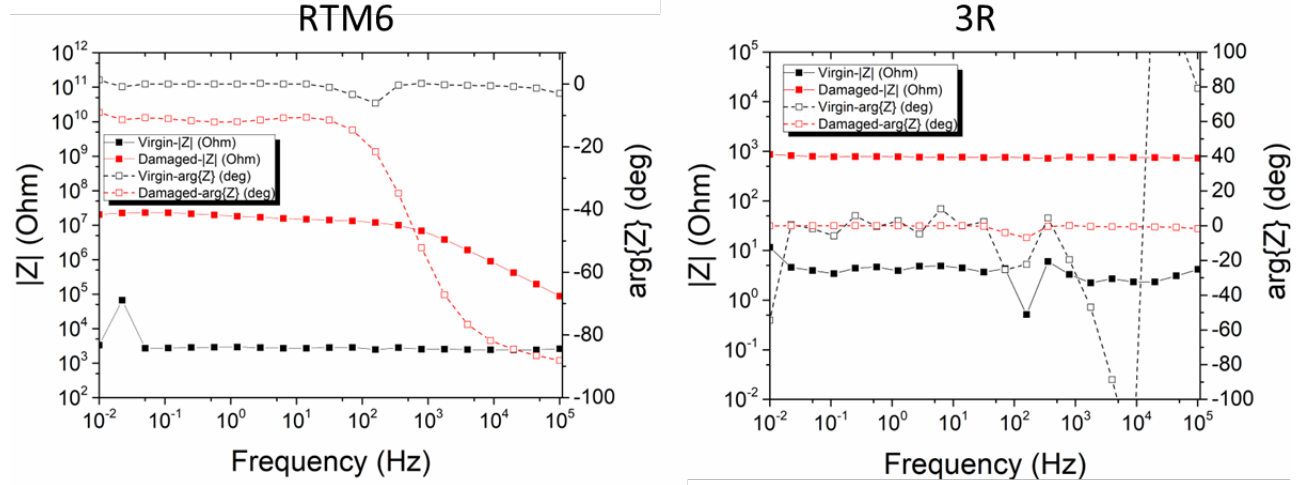
Figure 5. IS scans of ( left ) a representative RTM6 ILSS specimen before (black) and after damage (red), and ( right ) a 3R specimen before (black) and after damage (red).